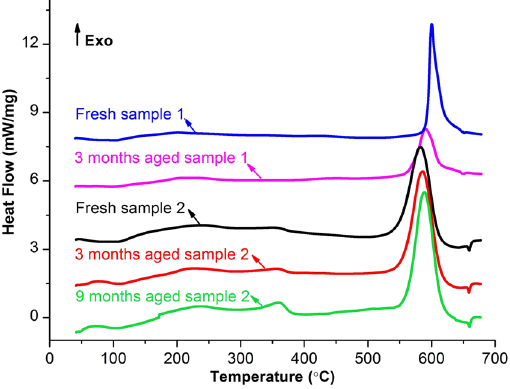
Figure 7. DSC curves of freshly prepared and aged samples of Si-W/MnO 2 /Al (sample 1) and Si-W/MnO 2 /Al/ fluorocarbon (sample 2).